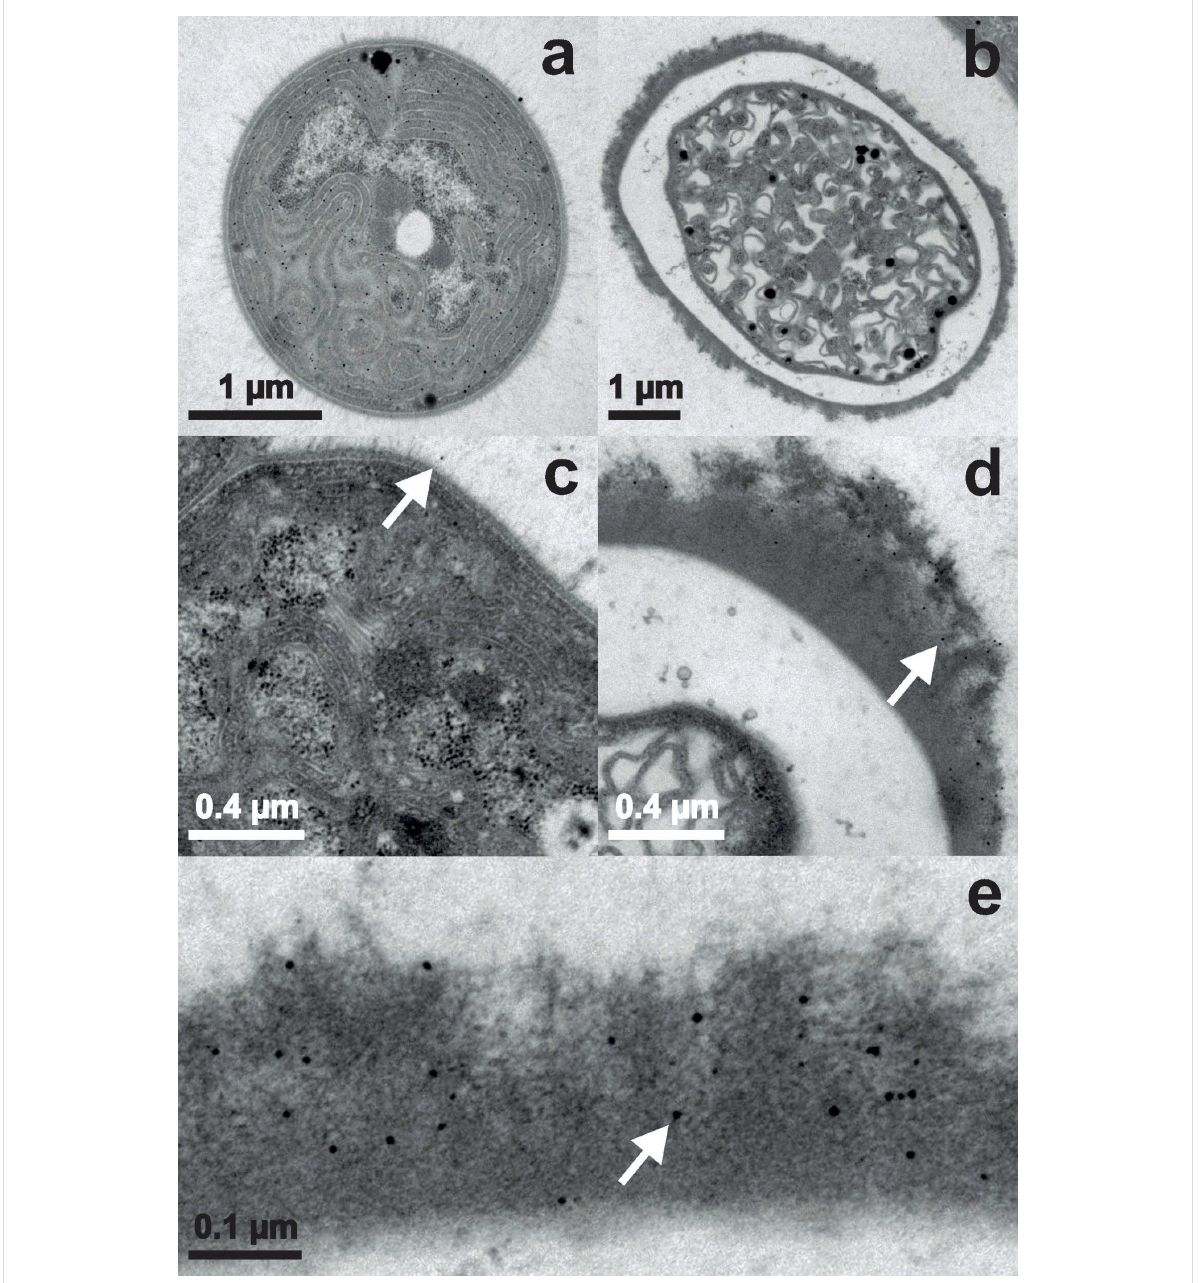
Figure 3: TEM images of Anabaena cylindrica incubated with an overall concentration of 0.8 mM Au 3+ for 15 minutes. Vegetative cells are displayed in panels (a) and (c), heterocysts in panels (b), (d) and (e). The white arrows guide the eye to one already formed nanoparticle in each panel with larger